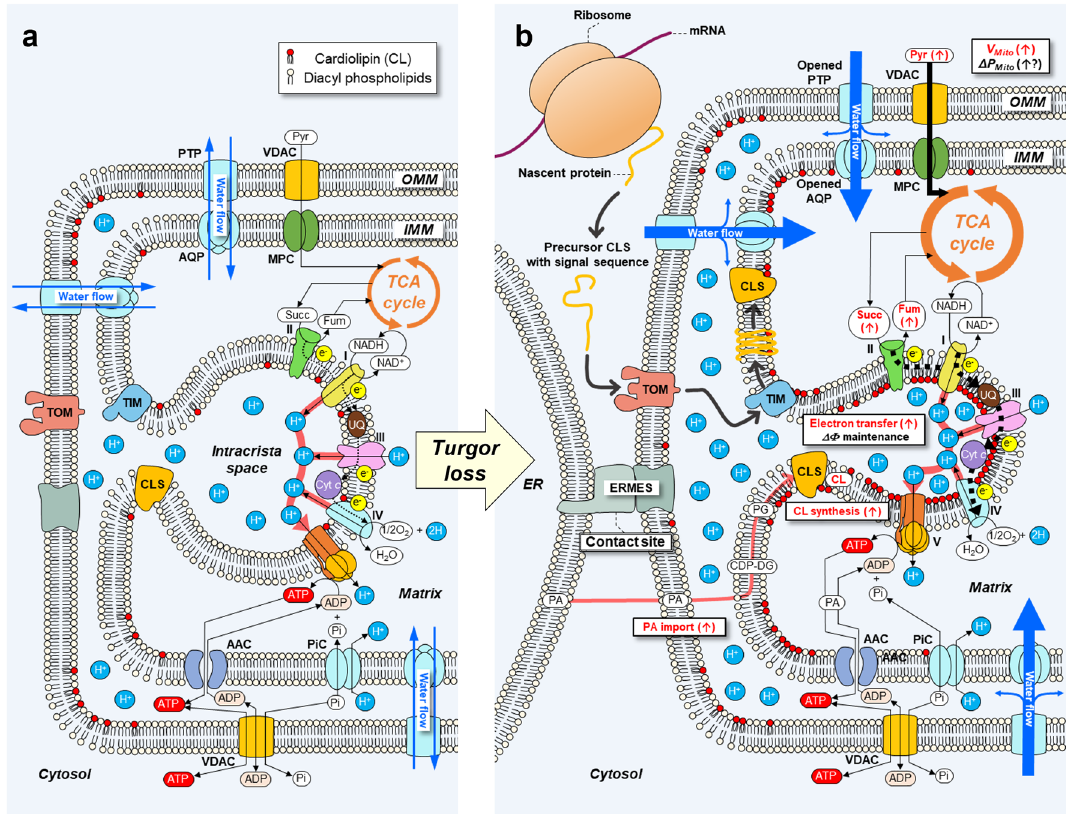
Figure 5. Putative model of mitochondrial volume regulation and electron transport chain associated with turgor-driven cardiolipin (CL) biosynthesis. Mitochondrial energy production 46 under normal conditions ( a ) and salt stress conditions ( b ). Turgor loss may be transmitted to the nucleus and membranes as a hydraulic signal, which may upregulate nuclear cardiolipin synthase (CLS) gene expression 47 as well as the opening of putative permeability transition pore (PTP) 39 and aquaporins (AQPs) 38 in each mitochondrial membrane (see text). These responses would lead to temporal expansion in mitochondrial volume ( V Mito ) and CL accumulation. In the cytosol, the newly translated precursor CLS proteins would be imported into inner mitochondrial membrane (IMM) through translocase of the outer membrane (TOM) 48 and incorporated into IMM through translocase of the inner membrane (TIM) 48 . And, the three-dimensional structure of CLS would be properly formed in IMM to exhibit enzyme activity. At the endoplasmic reticulum (ER)-mitochondrial connection, phosphatidic acid (PA) may be imported from ER to IMM through outer mitochondrial membrane (OMM) 49 , and thereafter PA would be synthesized throughout several steps in phospholipid biosynthesis to form CL, resulting in an increase in the curvature of IMM 50 . The different dipole moments and dipole density both cause a net polarization 51 . The maintenance of mitochondrial membrane potential difference ( ΔΦ ) streamlines electron transfer and H + transfer by respiratory chain complexes (see Fig. S16 for more details). As the result, the maintenance of H + gradient contributes to ATP synthesis even under salt stress conditions, sustaining the cytoplasmic streaming velocity. VDAC; voltage-dependent anion channel; MPC: mitochondrial pyruvate carrier; TCA: tricarboxylic acid; Pyr: pyruvate; Succ: succinate; Fum: fumarate; NAD + : nicotinamide adenine dinucleotide; NADH: nicotinamide adenine dinucleotide hydrate; UQ: ubiquinone; Cyt- c : cytochrome c ; ADP: adenosine 5’-diphosphate; PiC: phosphate carrier; AAC; mitochondrial ADP/ATP carrier; ERMES: ER-mitochondria encounter structure 52 ; mRNA: messenger ribonucleic